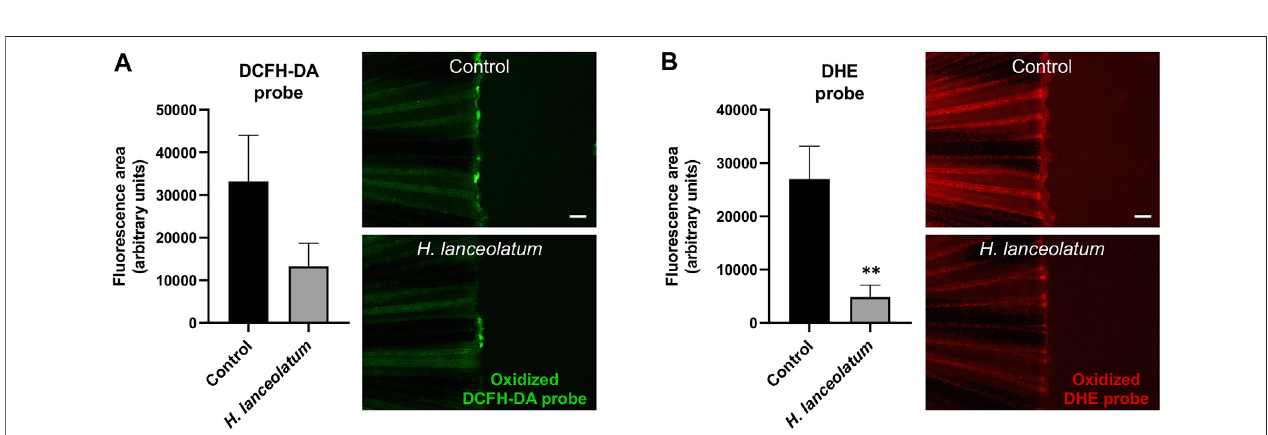
FIGURE 6 | H. lanceolatum aqueous extract exhibits preventive antioxidant effect after caudal fi n amputation. Fluorescence quanti fi cation and representative pictures ofoxidized (A) DCFH-DA and (B) DHE probes after caudal fi n amputation of adult zebra fi sh pre-incubated in water (Control) or H. lanceolatum aqueous extract at the MNTC (0.3125 g/L H. lanceolatum ). Results are expressed as means ± SEM ( n = 9/group from 3 independent experiments). ** p < 0.01 (Student t-test). Bar = 200 µm.